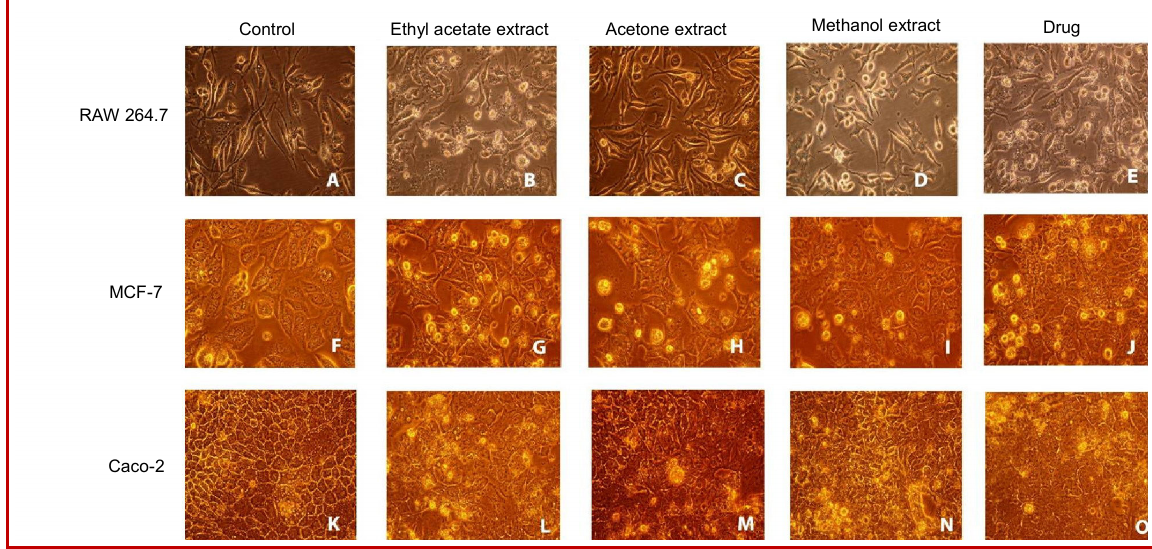
Figure 6: Images of cells in MTT assay by the effect of P. mollis extracts